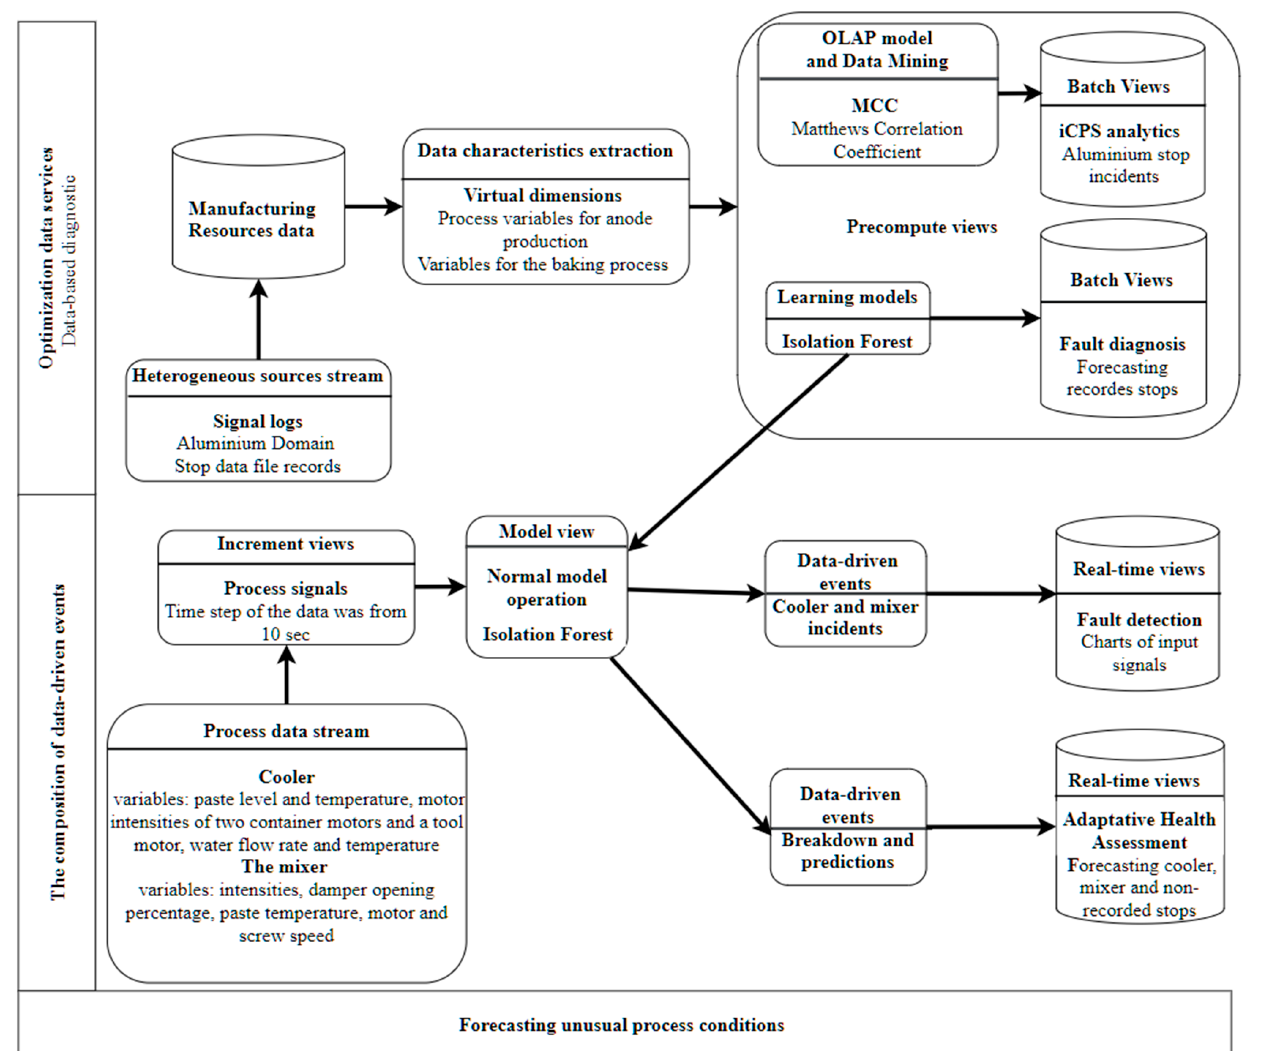
Figure 14. Instance for forecasting unusual process conditions for an adaptive health